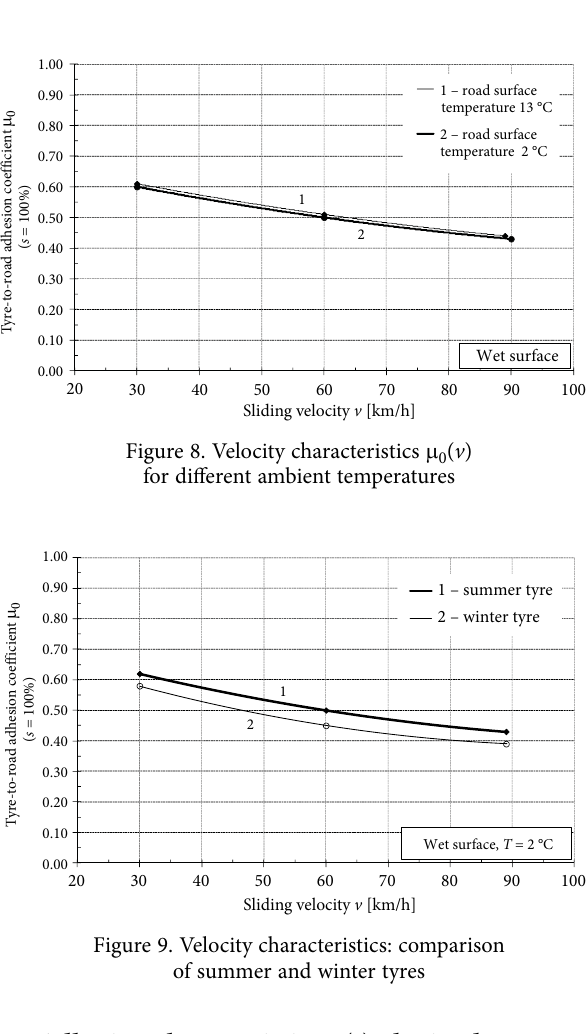
Figure 7. Exemplary velocity characteristic m 0 ( v )